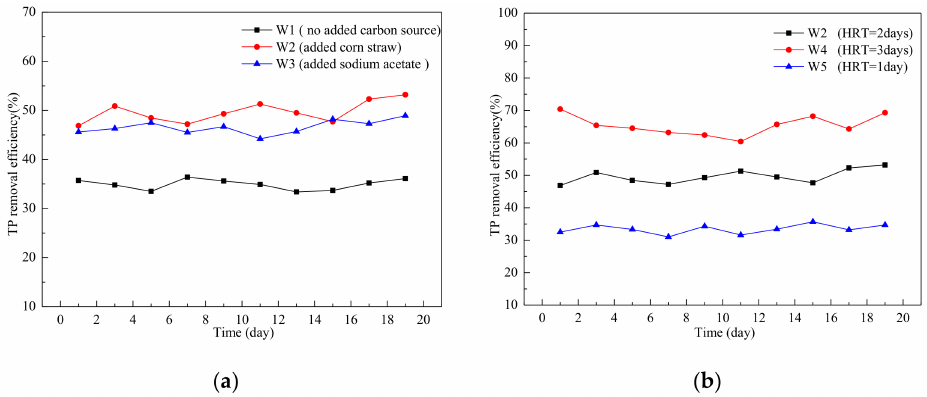
Figure 7. Effects of carbon source and HRT on TP removal: ( a ) carbon source; ( b )